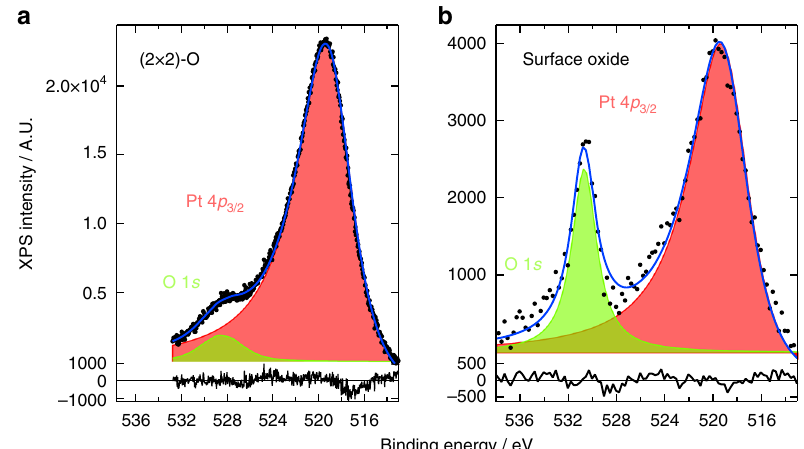
Fig. 4 XPS after oxidation. XP spectra collected after exposure of a clean Pt(111) sample to 400 L O 2 at room temperature ( a ) and to 1.0 bar O 2 at 441 – 444 K for 60 min ( b ). Spectra were fi tted with a Doniach – Š unji ć function convoluted with a Gaussian: O 1 s ( green ) and Pt 4 p 3/2 ( pink ). Lower panels show the fi tting residual. To obtain a good fi t, the Pt 4 p 3/2 peak required considerable asymmetry in